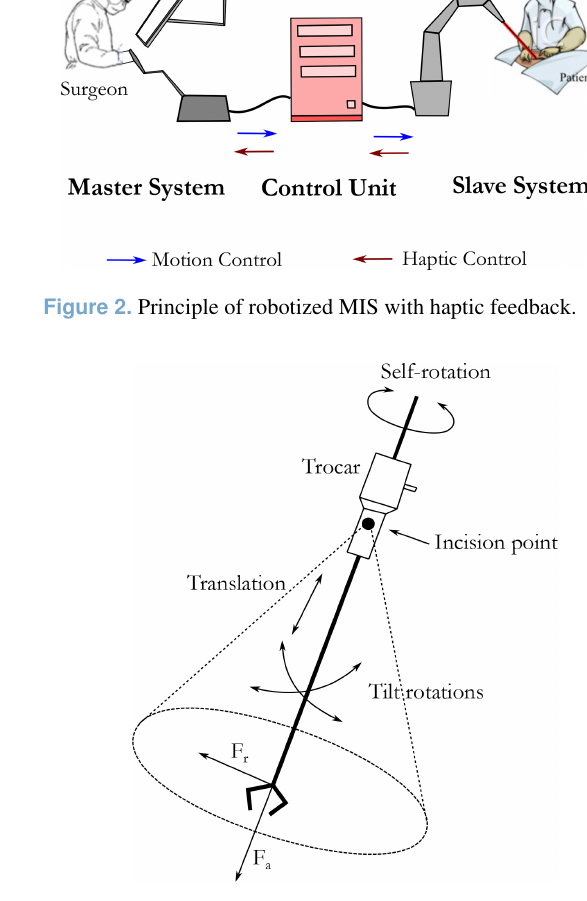
Figure 3. Workspace illustration of